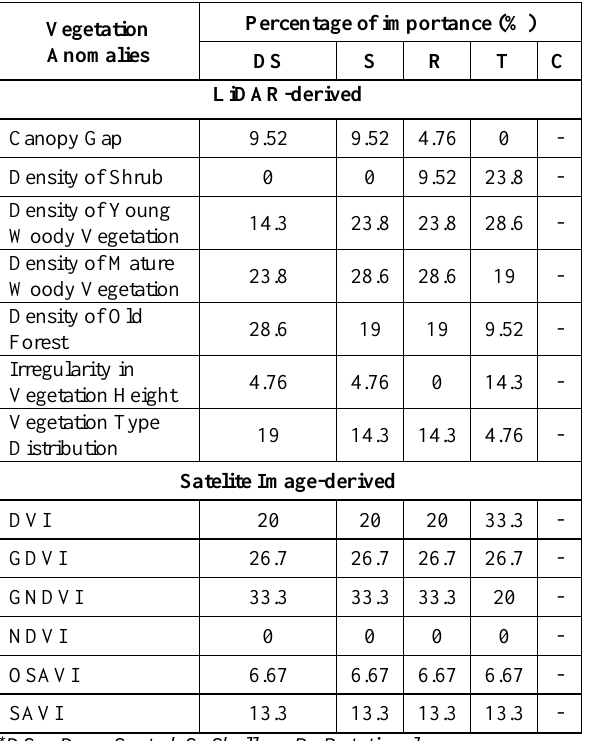
shown as the most frequent vegetation index class in rotational active. This is because low DVI value indicates that low photosynthesis process has occurred. Next, grass was shown as the most important indicator in characterizing complex active landslides. Complex active landslides happened when two (2) or more landslide types occurring in a landslide area. The presence of woody vegetation is the least important indicator that can be derived from complex active landslide area. NDVI with range from negative value to 0.1 indicates as the most importance characteristic of complex active landslides. This range is representing nearly non-vegetated area. Next, vegetation anomalies index for dormant landslide activity can be seen in Table 7.